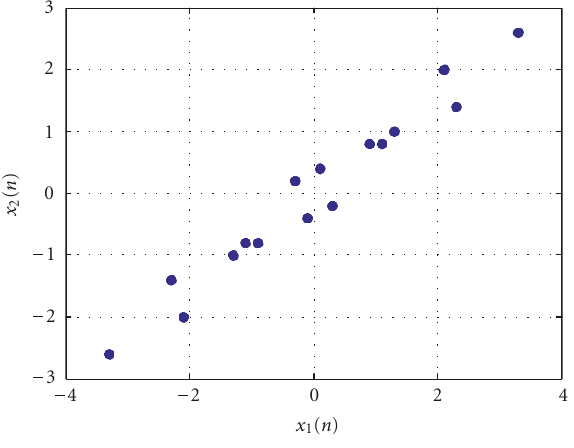
Figure 5: Joint distribution of the mixture signals.